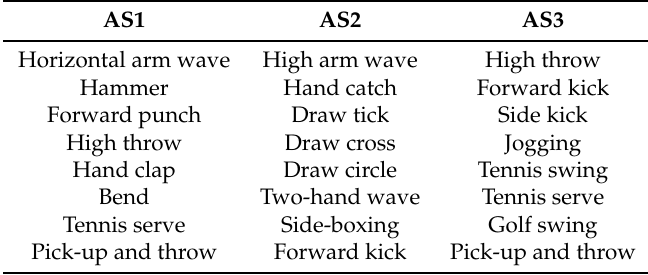
Table 7. Subsets of MSR action 3D dataset